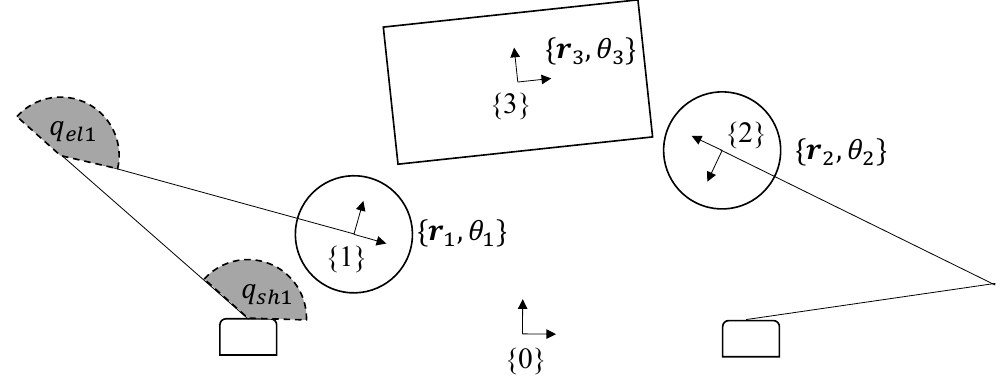
Figure 3. Dual − arm robot kinematic variables.